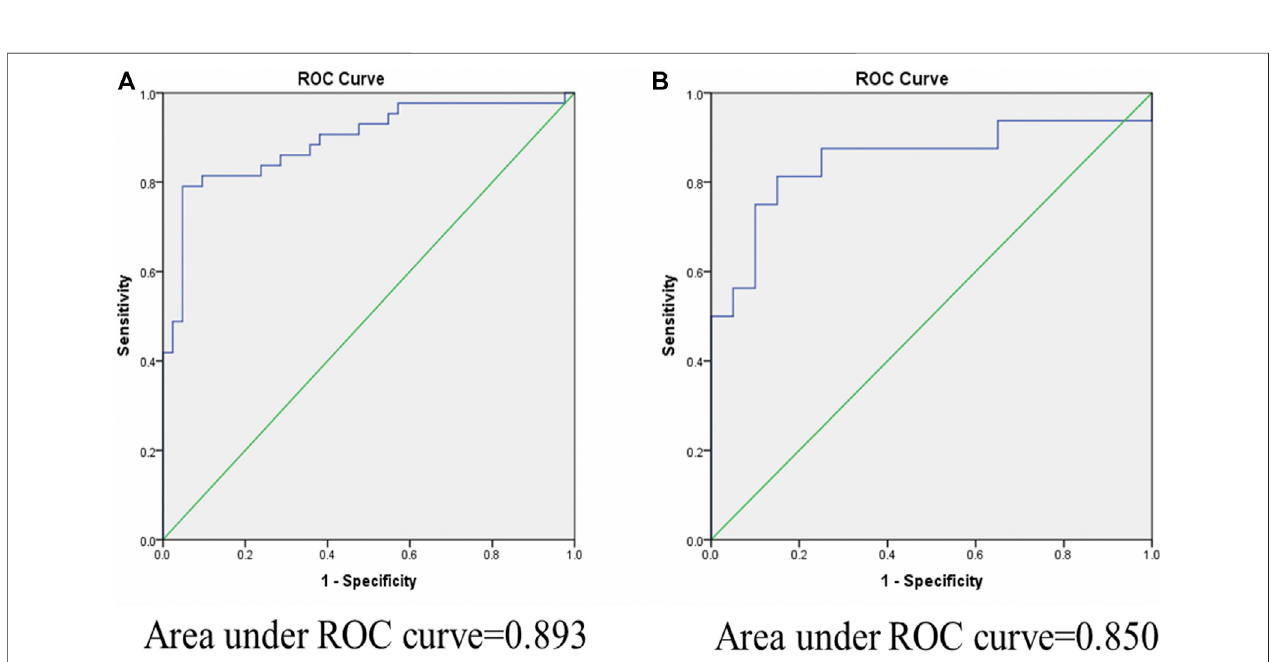
Frontiers in Molecular Biosciences |